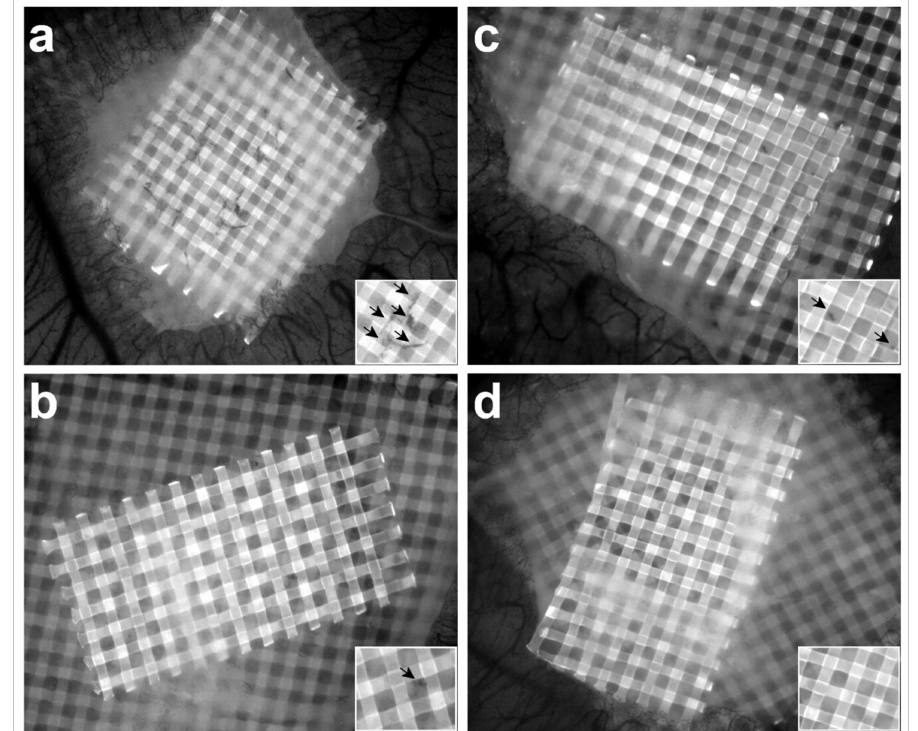
Figure 4. Collagen/mesh onplants were placed on the CAM and visualised after 3 days to allow quantification of angiogenesis. Blood vessels growing above the plane of the top mesh in the collagen plug can be seen as black structures (arrows in insert) against a grey mesh on images taken in the DAPI channel (excitation, 358 nm; emission, 463 nm). Representative images of angiogenic HT1080 plugs of control embryos ( a ) and macrophage-depleted embryos ( b ) and representative images of plain collagen plugs of control embryos ( c ) and macrophage-depleted embryos ( d ). Fewer blood vessels were observed in the plugs of macrophage-depleted embryos than in those of control embryos, both in the HT1080 plugs (( b ) versus ( a )) and the plain collagen plugs (( d ) versus ( c